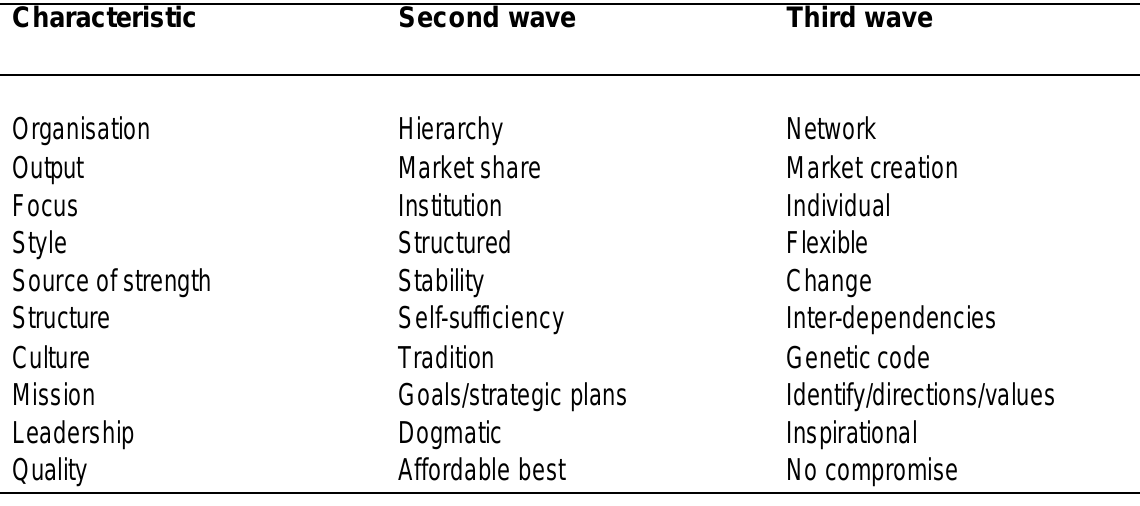
TABLE 1: CONTRASTING MANAGEMENT PARADIGMS